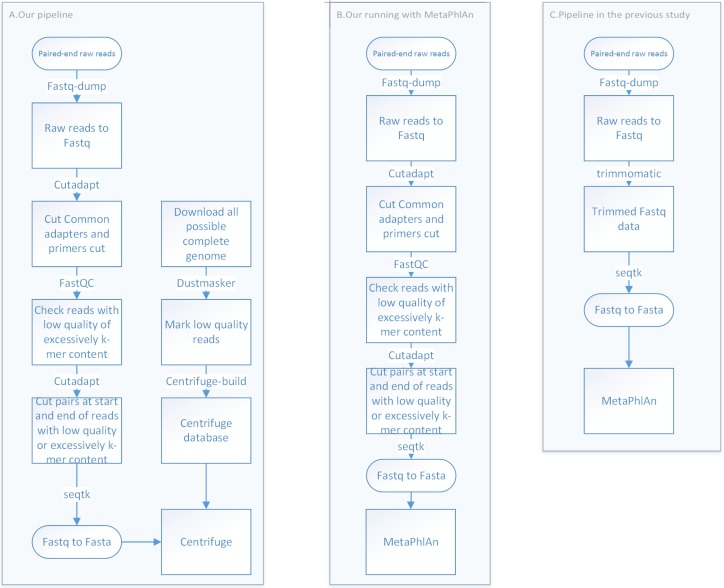
Pipelines to analyze shotgun metagenomic reads.The left panel shows our pipeline. Centrifuge outputs the reads mapped to the sequenced genomes, from which the read abundances of taxa, Mann-Whitney p-values, and correlations with colitis severity are calculated. The middle panel shows the analyses with MetaPhlAn by a different read trimming procedure from that in the original study. The right panel shows the pipeline using MetaPhlAn in the original study. As it is not clear which MetaPhlAn version was used in the original study, two versions of MetaPhlAn have been used for comparisons in this study.